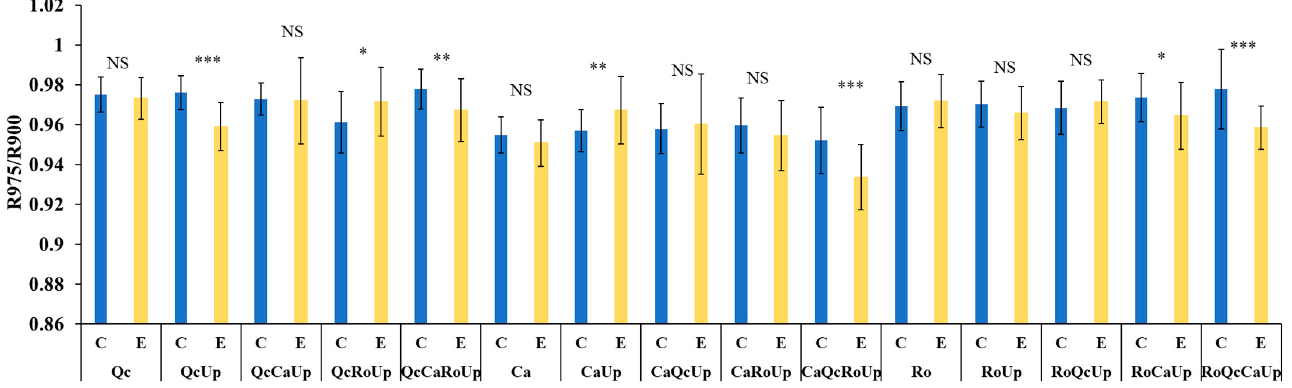
Figure 7. Histograms of drought index (R975/R900) of assemblages in control (C) and rain-exclusion (E) conditions. Quercus coccifera (Qc), Cistus albidus (Ca) and Rosmarinus officinalis (Ro) and Ulex parviflorus (Up). The first two letters of each assemblage indicate the species measured. NS, not significant; * p < 0.05; ** p < 0.01; *** p < 0.001. n = 27.